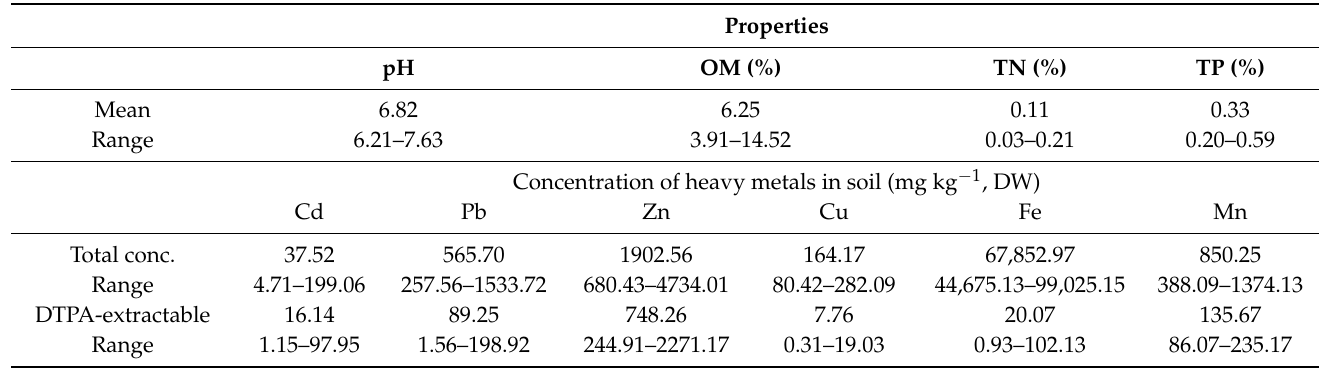
Table 2. Physicochemical properties and metal concentrations of the soil samples collected from the farmland around the tailings pond ( n = 36,